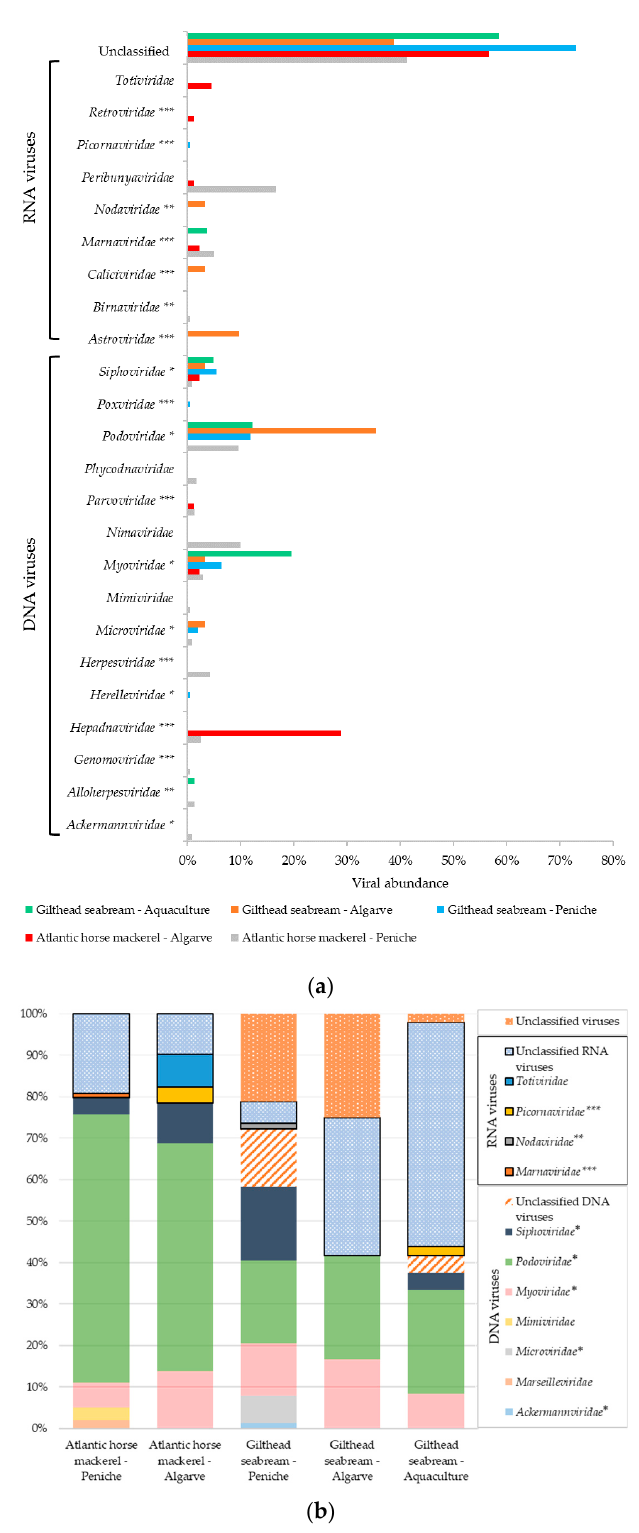
Figure 2. Blast results concerning viral diversity within each fish species and region. ( a ) Viral diversity in each fish species per region (including those contigs assigned as unclassified even within a family). ( b ) Viral diversity of unclassified viral contigs of each species per region. Bacteriophages families are pointed out with *, whereas pathogenic families for fish / other vertebrates and humans / other vertebrates are marked with ** and ***,